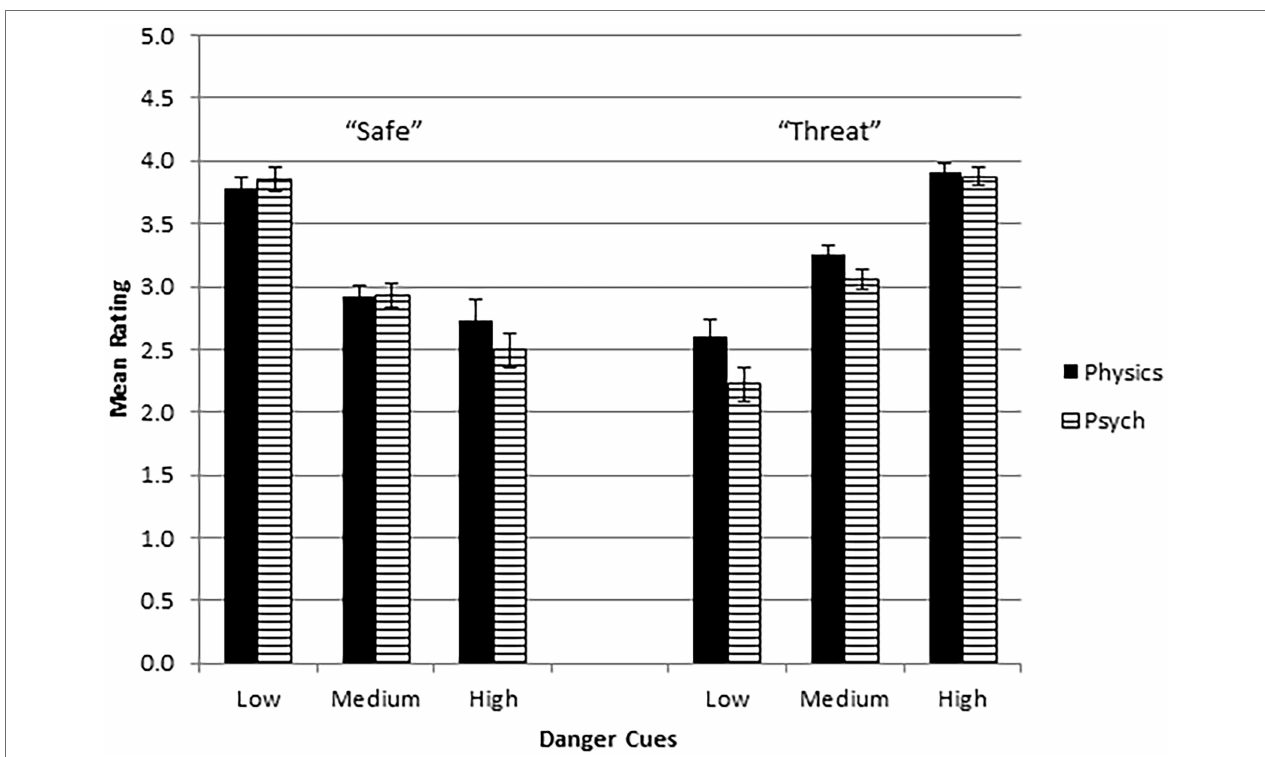
FIGURE 3 | Estimated marginal means for trust rating as a function of level of danger cues, robot decision (“Safe” or “Threat”), and mode of analysis (Physics = physics-based, Psych = psychological). Error bars are